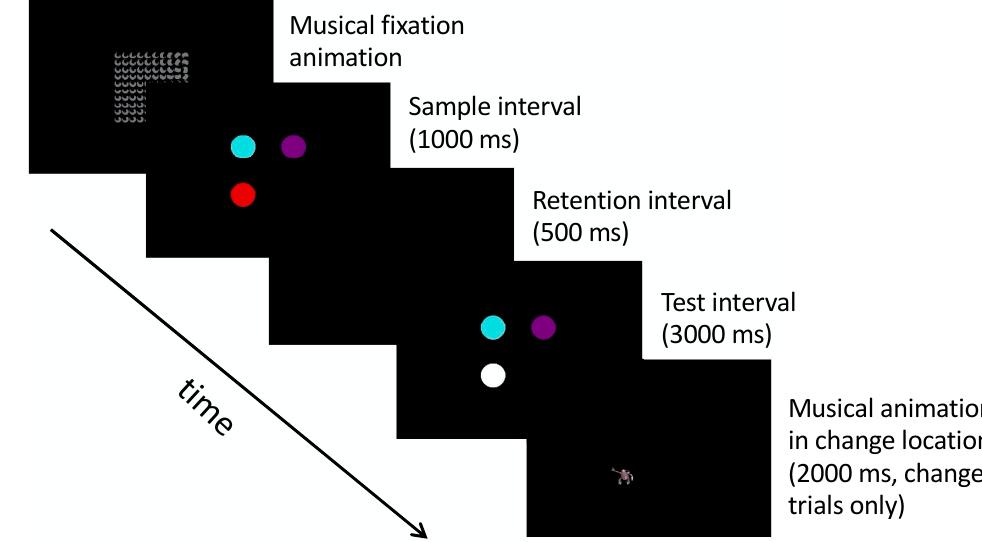
Figure 5. Example of a set size 3-change trial. No change trials were identical to change trials with two exceptions: First, the test array matched the sample array, and second, the test array was followed by a 2000 ms blank interval rather than a musical reward animation.